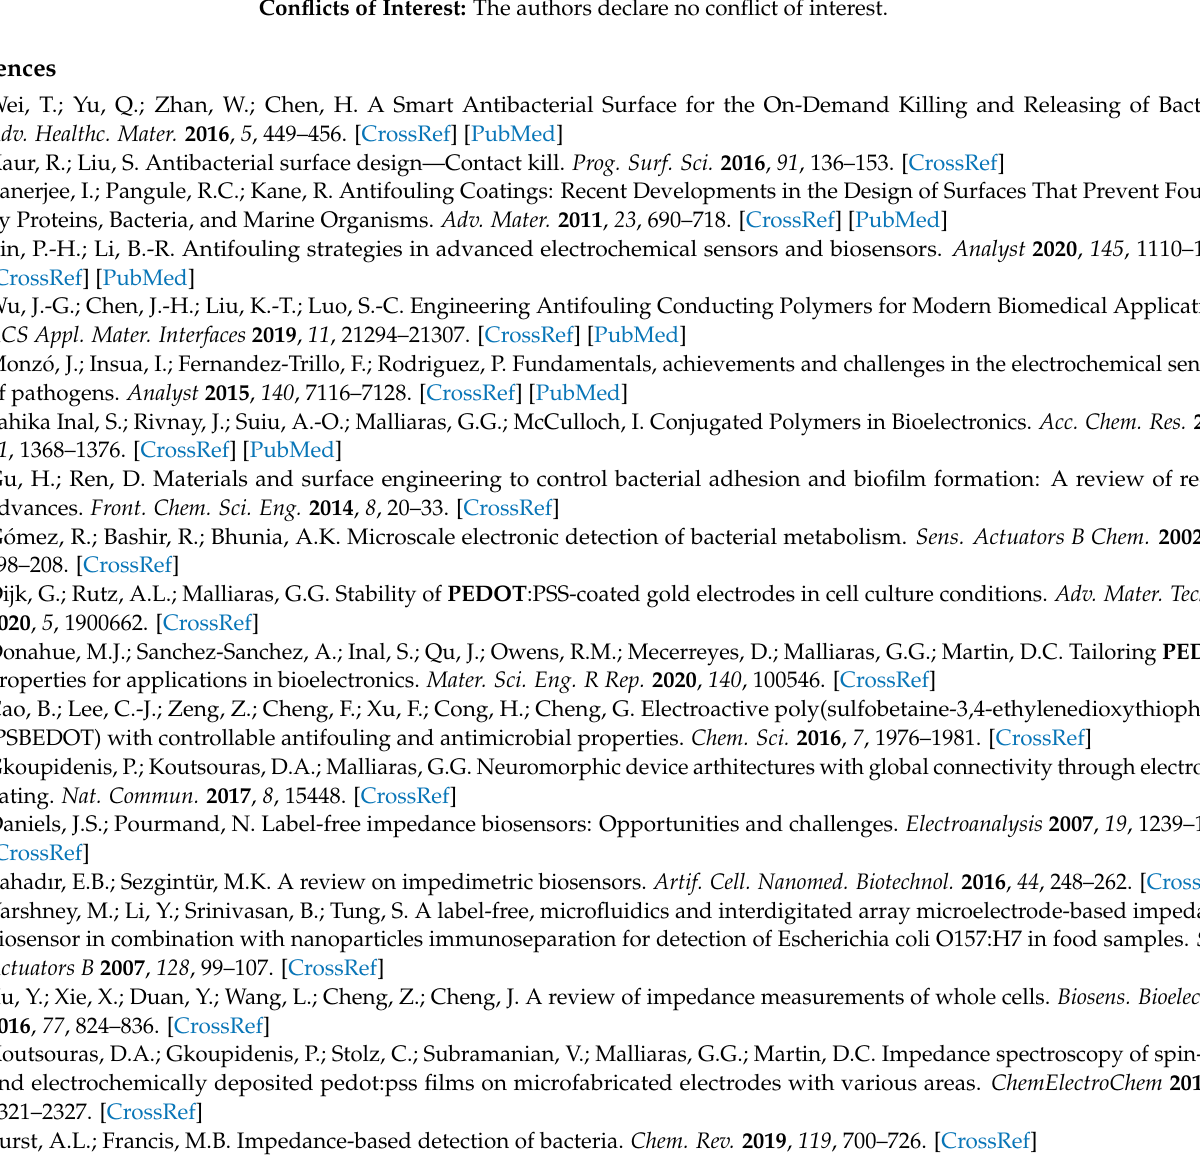
NaCl; Figure S5: Energy dispersive X-ray spectroscopy of PEDOT film ( top ) and PEDOT film with E. coli ( bottom ); Figure S6: SEM image of E. coli at PNaSS@PEDOT microspheres film oxidized at 0.7 V vs. Ag/AgCl reference electrode; Figure S7: SEM image of E. coli at oxidized PNaSS@PEDOT microsphere